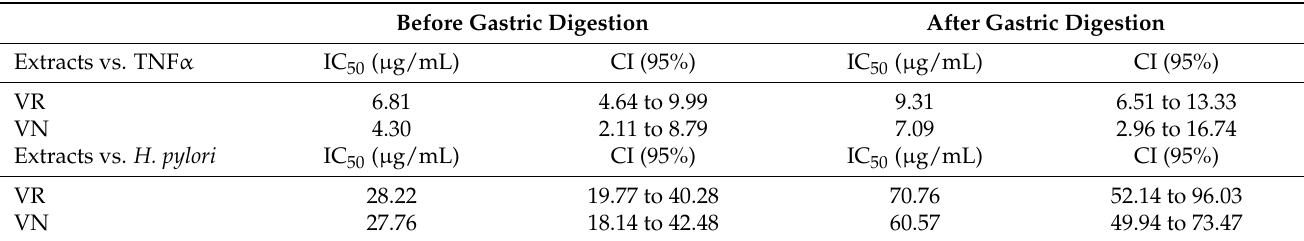
Table 4. IC 50 ( µ g/mL) of the Castanea sativa Mill. extracts on IL-8 release.